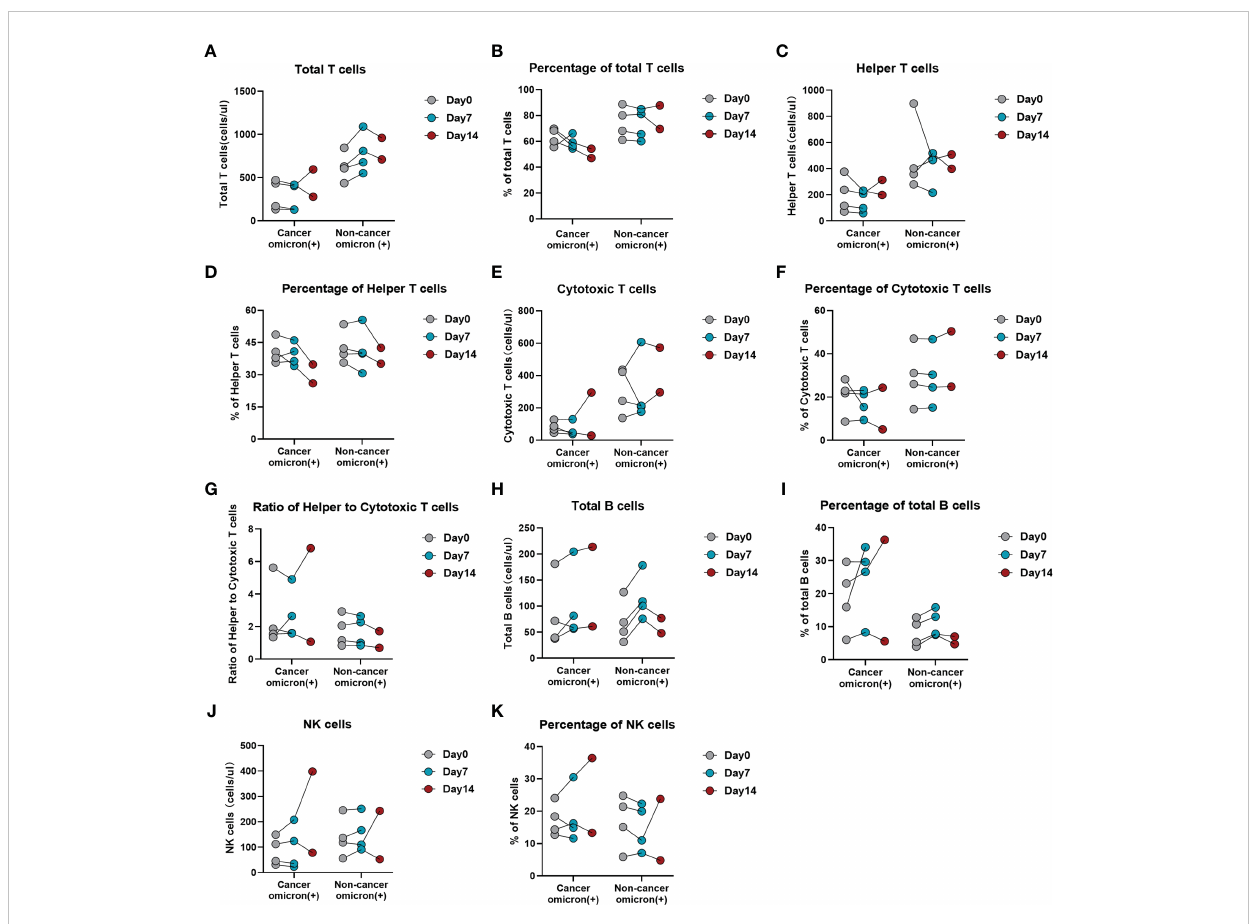
FIGURE 6 Time-course variations of lymphocyte subsets in Omicron infected patients with or without cancer disease. Group 1 were cancer patients with Omicron infection, and Group 3 were non-cancer patients with Omicron infection. The comparisons of results from three timepoint detections of count of total T cells (A) , percentage of total T cells (B) , count of helper T lymphocytes (C) , percentage of helper T lymphocytes (D) , count of cytotoxic T cells (E) , percentage of cytotoxic T cells (F) , ratio of helper to cytotoxic T lymphocytes (G) , count of total B cells (H) , percentage of total B cells (I) , count of NK cells (J) , and percentage of NK cells (K) between Groups 1 and 2 during clinical